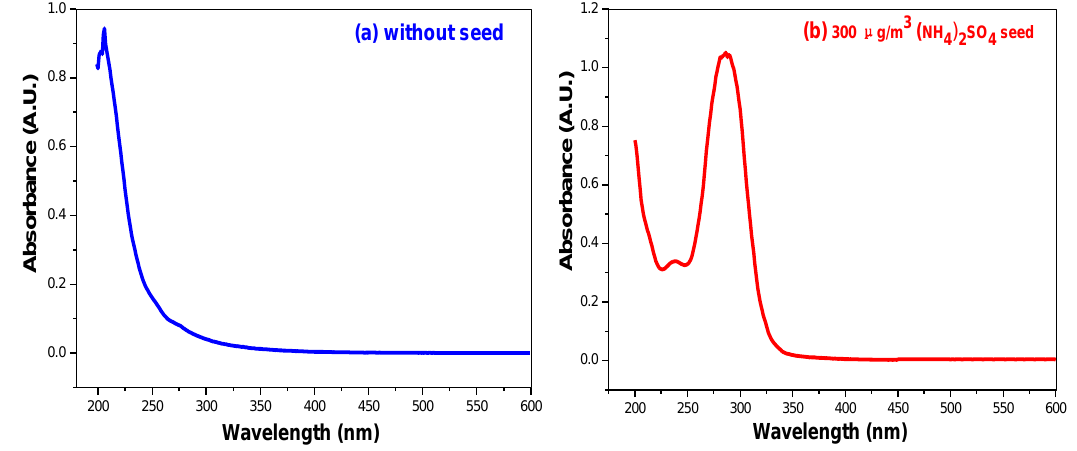
Figure 8. UV-Vis spectra of the SOA ( a ) without and ( b ) in presence of 300 µ g / m 3 (NH 4 ) 2 SO 4 seed. Toluene SOA concentration formed in the presence of 300 μg/m 3 (NH 4 ) 2 SO 4 seed at the end of the reaction is about 340 μg/m 3 , and the mass of collected particles is estimated to be about 240 μg. In order to estimate the mass of the collected toluene SOA formed in the presence of seed, 300 μg/m 3